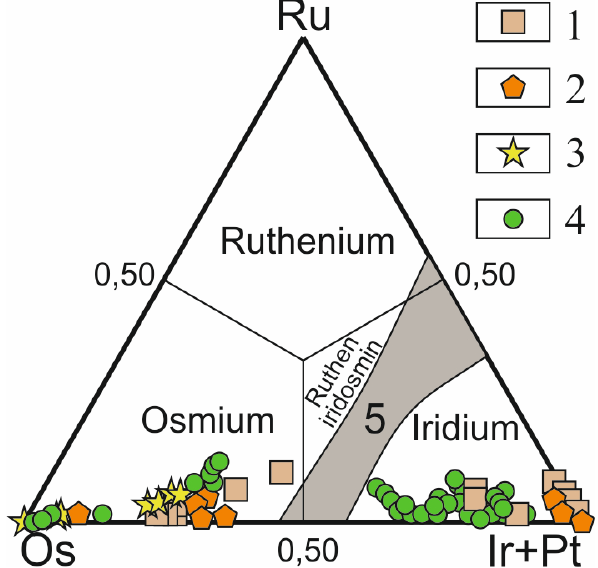
Figure 9. Composition (at. %) of Os-Ir-Ru inclusions in Pt-Fe alloys from the lode chromite-platinum mineralization (1), the Vershinniy eluvial placer (2), the Travyanistyi proximal placer (3), and Glubokinskoe distal placer (4). (5)—miscibility gap.